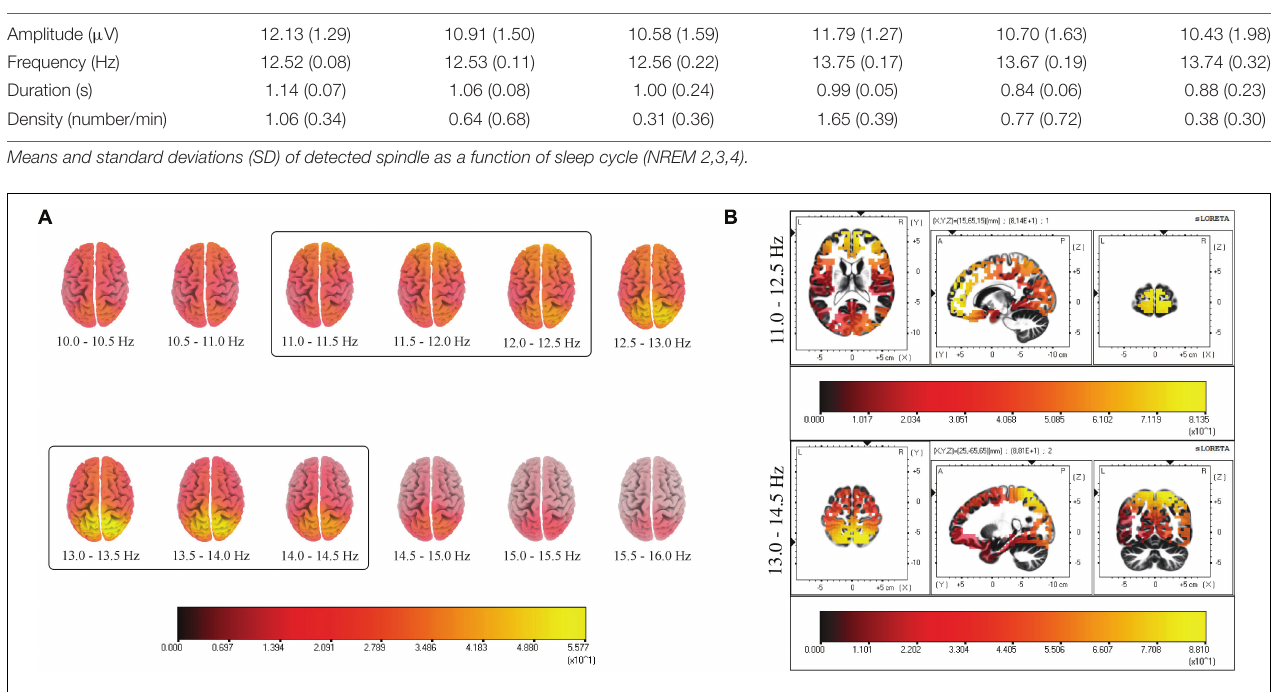
FIGURE 1 | (A) Distribution of mean CSD of the whole spindle frequency range (10.0–16.0 Hz) with a frequency bin resolution of 0.5 Hz. The maximum of the estimated source is indicated in yellow. The prevalent source localization is situated over the anterior regions for low-frequency spindles and posterior regions for high-frequency spindles. (B) Distribution of mean CSD of slow (11.0–12.5 Hz) and fast (13.0–14.5 Hz) spindles in NREM sleep cycles. Two local maxima are identified: BA10 and BA7. Each distribution is shown relative to its maximum (in yellow), using axial, sagittal, and coronal slices intersecting at the point of maximal